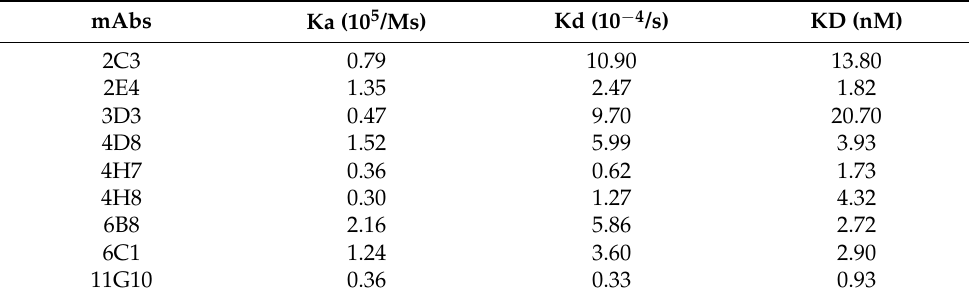
Table 1. The binding affinity of nine mAbs to gp42 were measured by SPR.